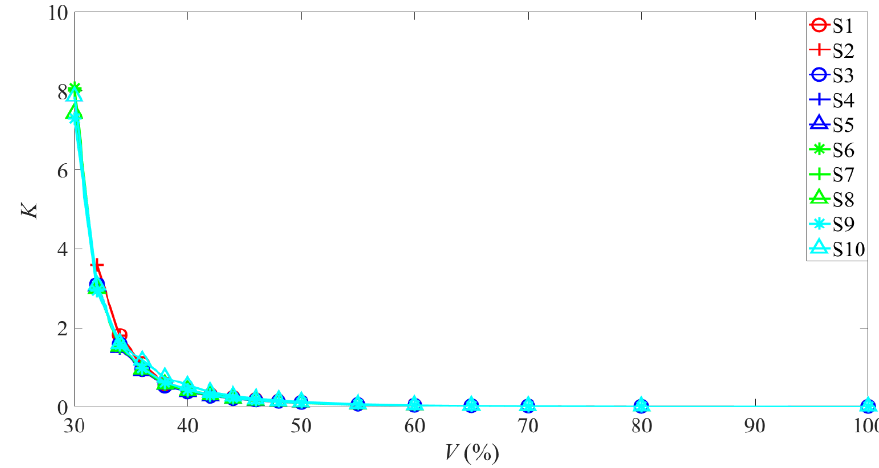
Figure 4. The curve of K values with valve opening at different speeds.